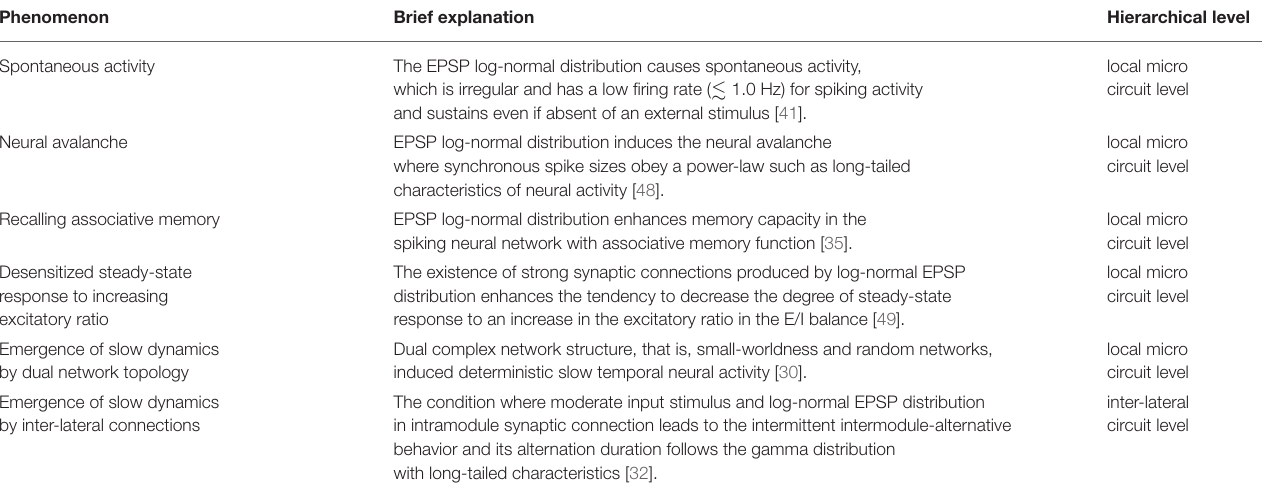
TABLE 1 | Modeling studies using log-normal excitatory postsynaptic potential (EPSP)